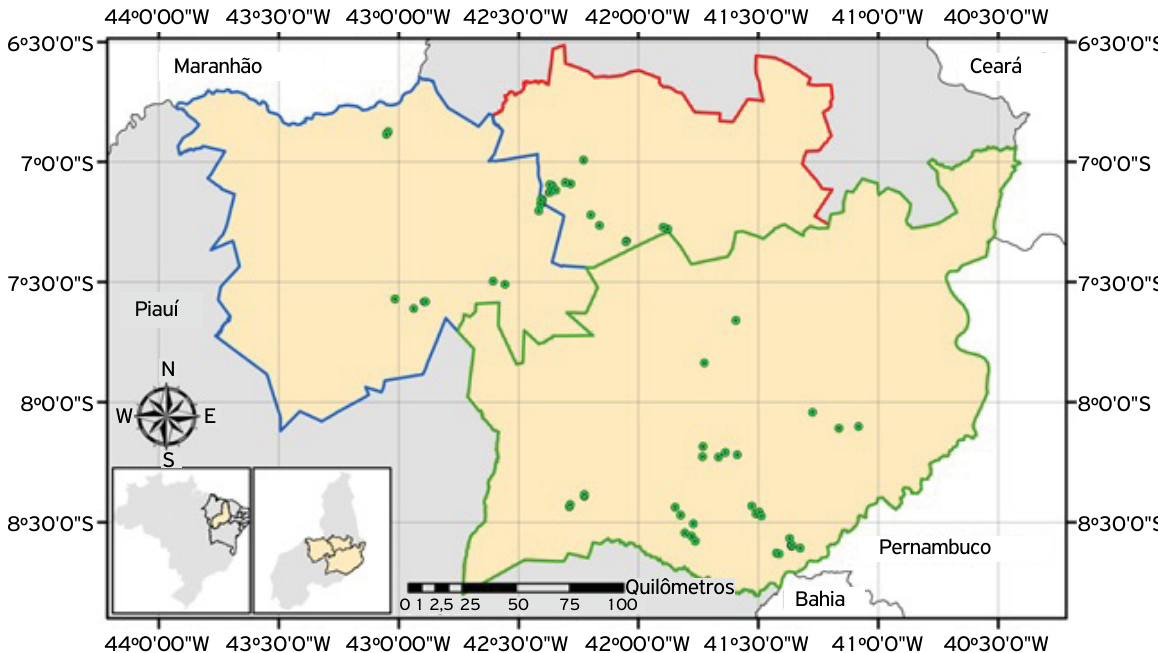
Figura 2. Localização georreferenciada das unidades produtoras de caprinos que participaram do estudo nas microrregiões do Alto Médio Canindé, Picos e Floriano, Piauí, Brasil.